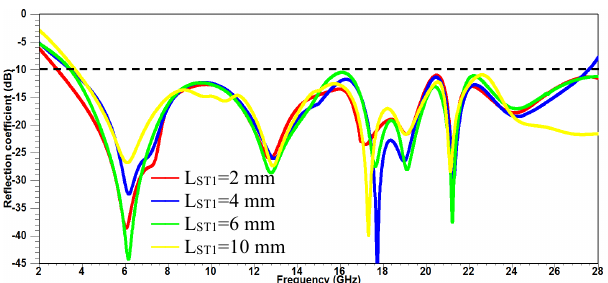
Figure 3: Simulated reflection coefficient for various antenna structures shown in Figure 2.